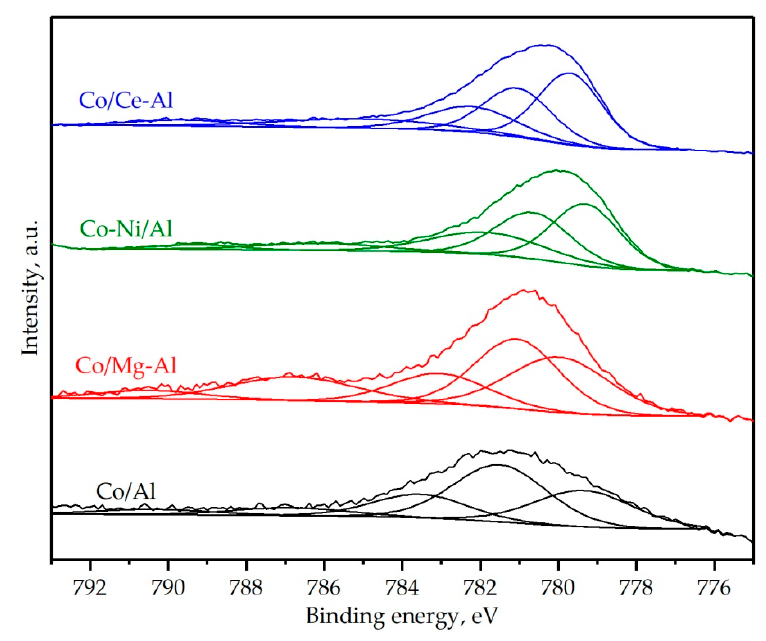
Figure 6. Co2p 3 / 2 XPS spectra of the supported cobalt catalysts. Figure 6. Co2p 3/2 XPS spectra of the supported cobalt catalysts.